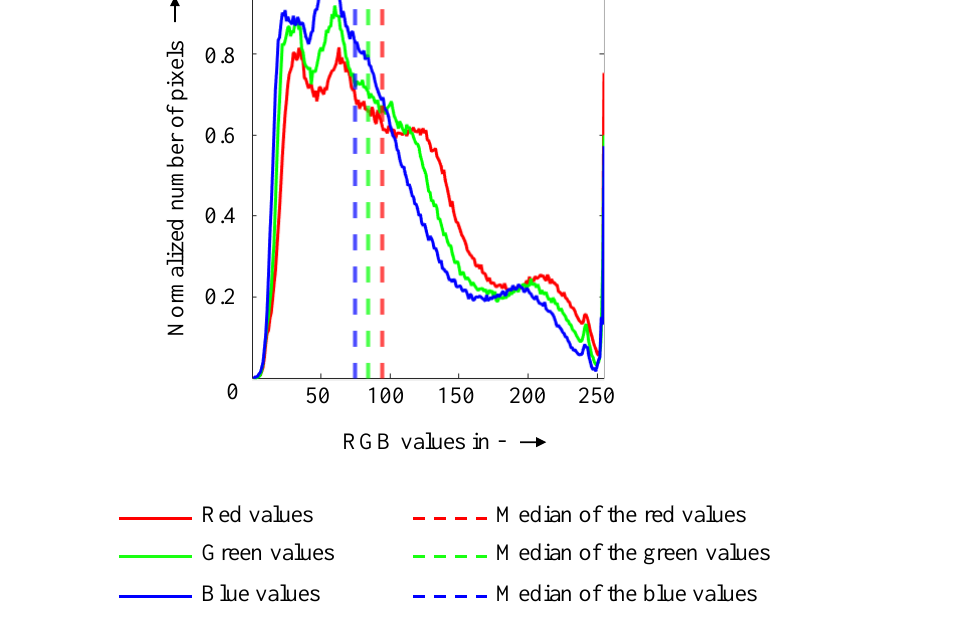
Figure 3. Exemplary histogram of the normalized number of pixels over the RGB values for a manufactured wall.